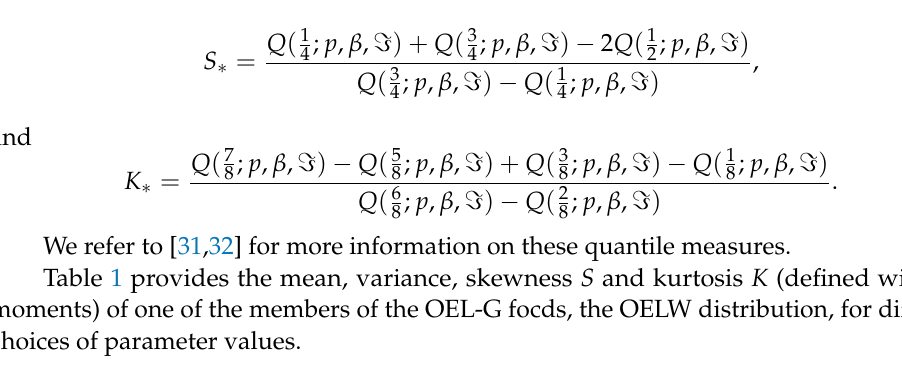
Table 1. Moment measures of the OELW distribution for various choices of parameters. Parameter Mean Variance Skewness Kurtosis